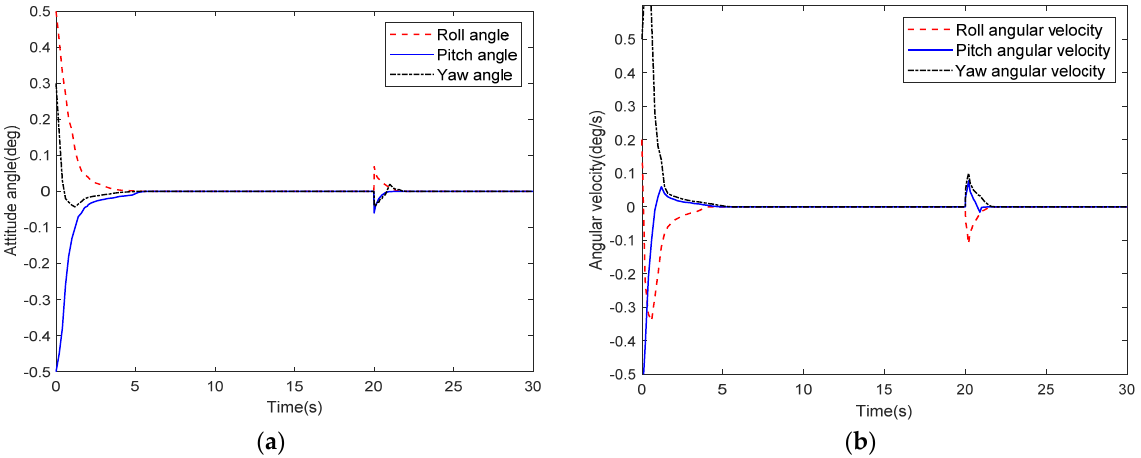
Figure 4. Variable structure FTC curves in multiple flight modes. ( a ) FTC response curves of attitude angles. ( b ) FTC response curves of angular velocities. Table 2. Comparative analysis of performance with the prior art in [32].